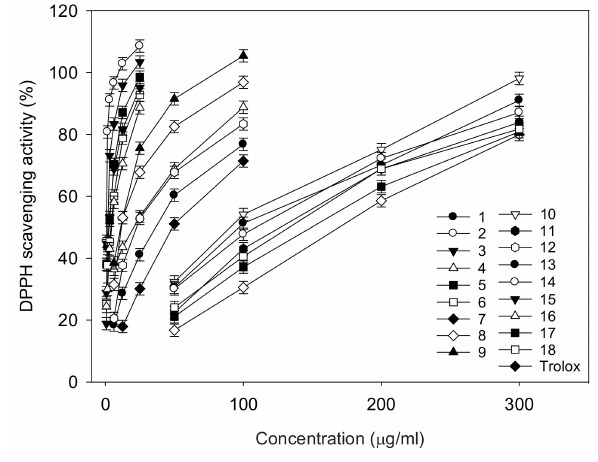
Figure 2. DPPH radical scavenging activity of compounds 1 – 18 and